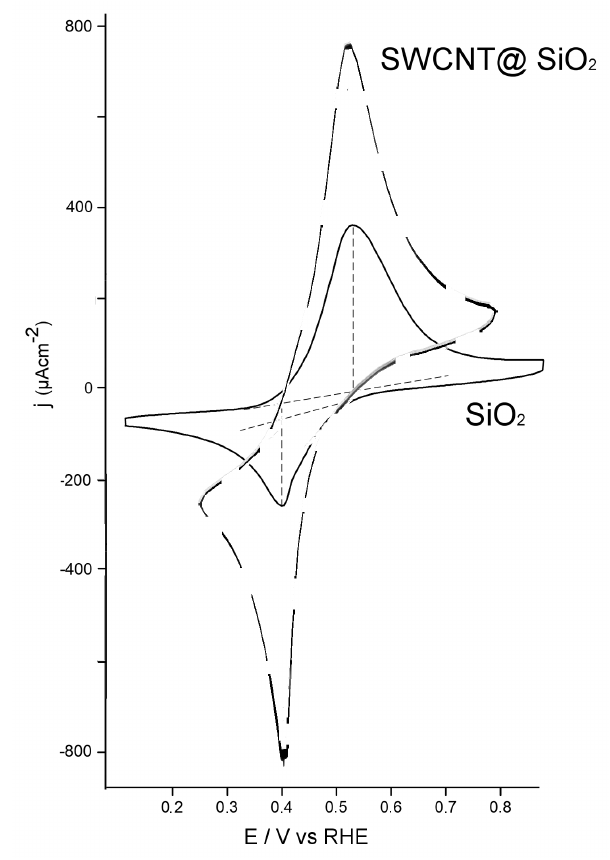
Figure 1. Stabilized cyclic voltammograms of a silica-modified electrode (solid line) and a Single-Wall Figure 1 . Stabilized cyclic voltammograms of a silica ‐ modified electrode (solid line) and a Single ‐ Wall Carbon Nanotubes in a silica matrix (SWCNT@SiO 2 )-modified electrode (dashed line) in a solution of Carbon Nanotubes in a silica matrix (SWCNT@SiO 2 ) ‐ modified electrode (dashed line) in a solution of 1.0 mM FcPF 6 in 0.5M H 2 SO 4 . Scan rate of 100 mV s − 1 . 1.0 mM FcPF 6 in 0.5M H 2 SO 4 . Scan rate of 100 mV s − 1 .